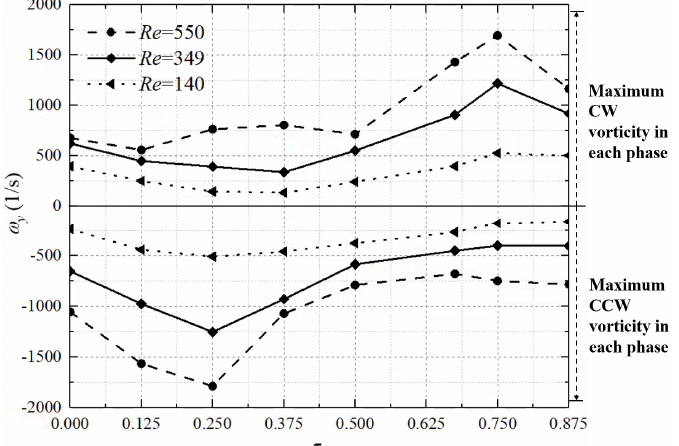
in the previous cycle starts to detach from the blade tip and the CW vortex generated in Figure 11. Maximum y -component of CW and CCW vorticity ( ω y , max ) at different phases. Figure 11. Maximum y -component of CW and CCW vorticity ( ω the previous cycle is dissipating.